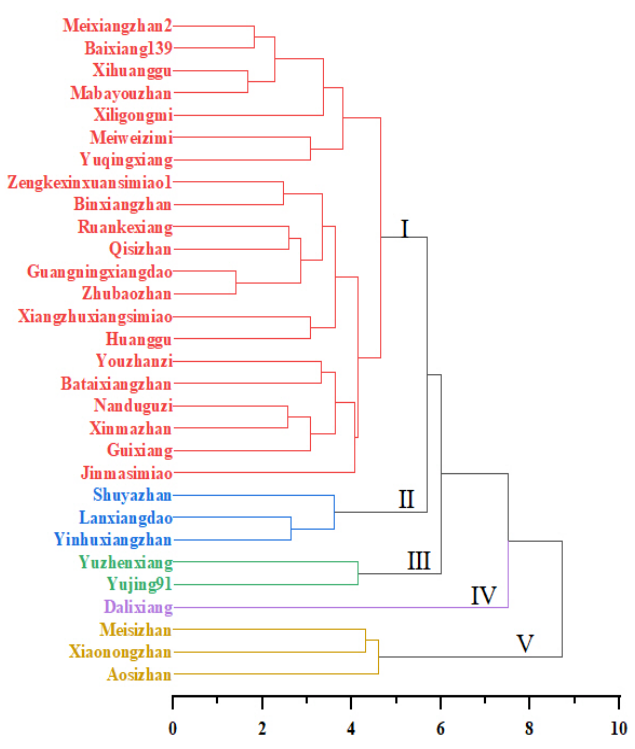
Fig. 2: Cluster analysis of 30 indica rice germplasms. Left are cultivar names. Cluster analysis is between groups method, measurement is squared Euclidean distance.